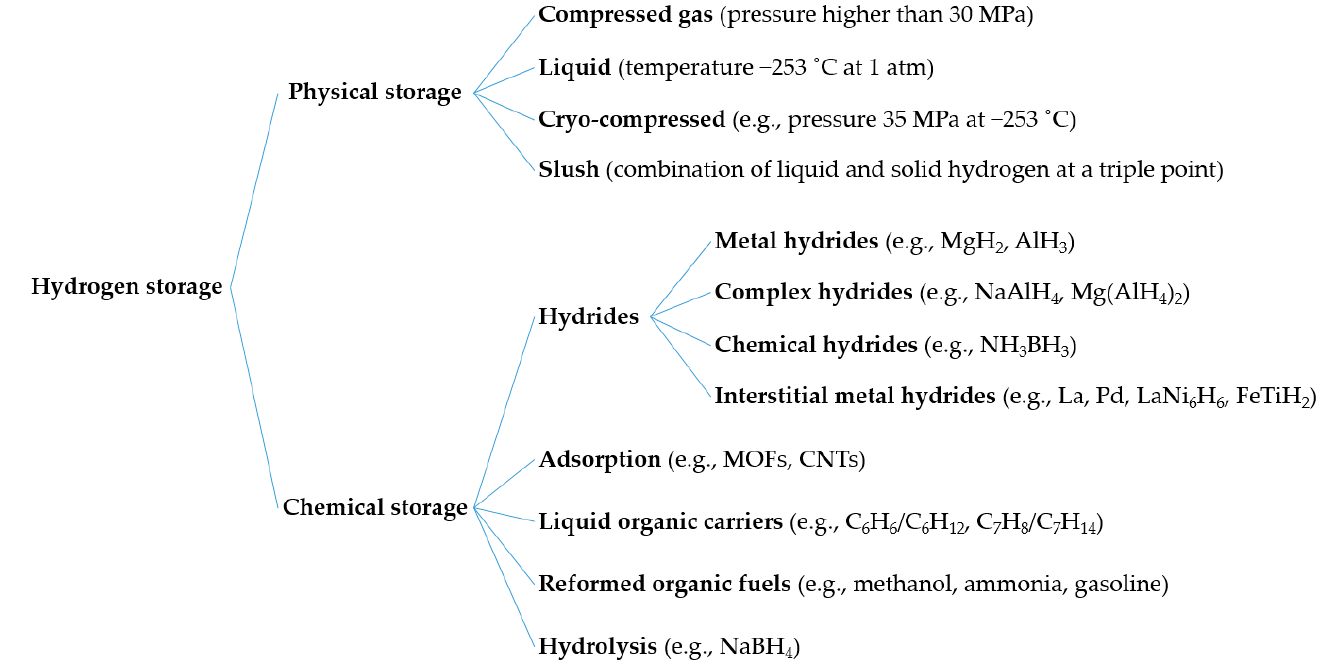
Figure 3. Hydrogen storage options, including physical and chemical storages.